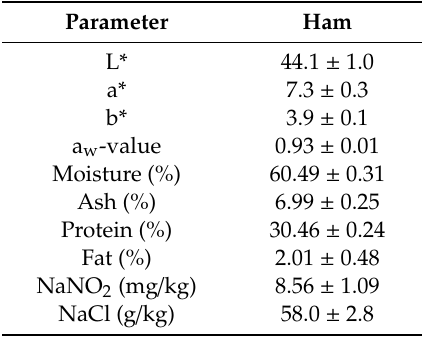
Table 1. Mean and standard error values of di ff erent quality parameters of the rolled fillets of ham after 6 weeks of storage / ripening ( n = 3).